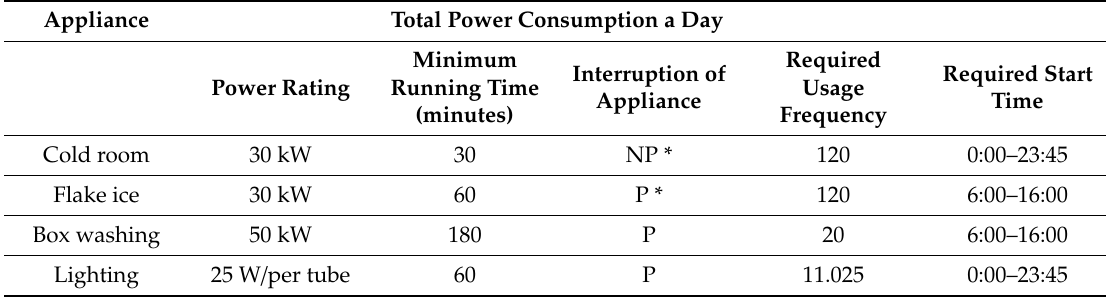
Table 4. Optimized appliances schedules for the Packaway